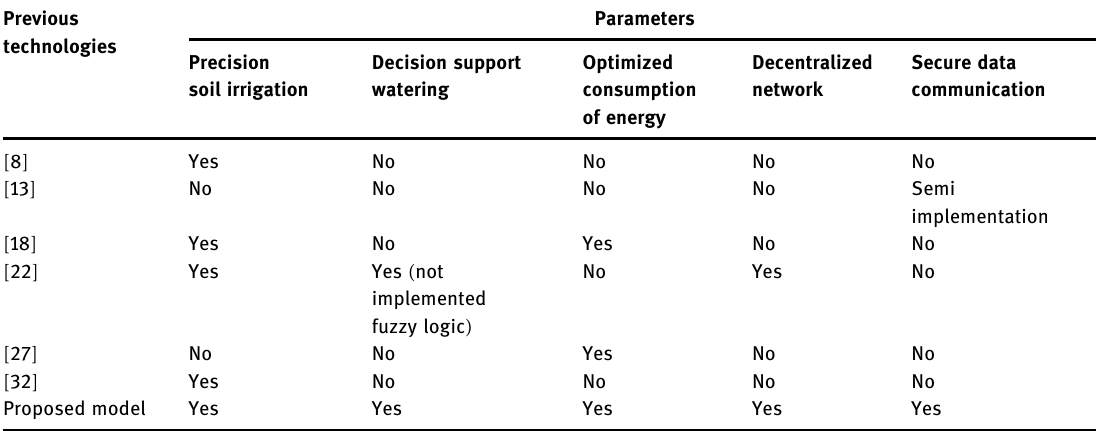
Table 1: Parameters comparison of proposed model with existing technologies